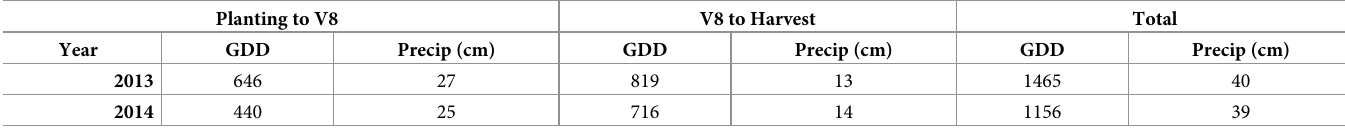
Table 4. Accumulated growing degree days (GDD) (base 10˚C) and precipitation amounts (cm) for each time frame after planting until sampling (Planting to V8), from sampling until harvest (V8 to Harvest), and season long (Total). Planting to V8